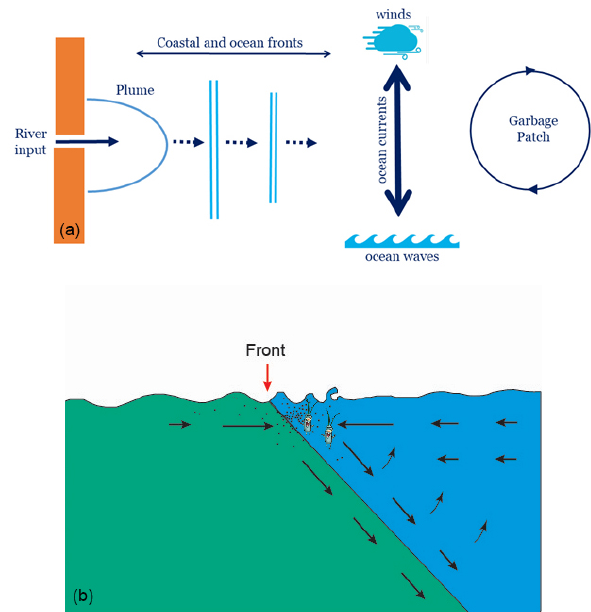
Figure 3. Schematic illustrating the different physical processes that control the transport of buoyant material from rivers to the open ocean (not to scale): (a) bird’s-eye view; (b) cross section showing convergence at the front and aggregation of buoyant material. When buoyant material is transported to the open ocean, it is transported by a combination of wind, waves, and ocean currents to the centre of ocean gyres forming the garbage